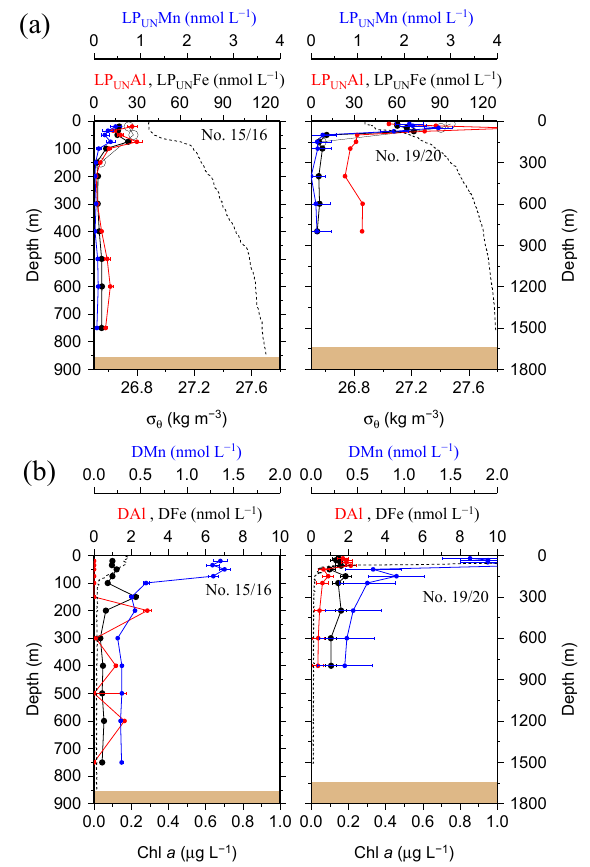
Figure 5. (a) OTE seawater samples: distribution of leachable par- ticulate manganese (LP Un Mn in blue), iron (LP Un Fe in black), and aluminium (LP Un Al in red) concentrations in the water column of the two other stations located on the island shelf edge (>700m wa- ter depth). SAPS samples: the particulate Fe (PFe) is illustrated by black circles and corresponds to the concentration labels of LP Un Fe. Error bars represent the standard deviation of the analysis. Density ( σ θ ) is illustrated by the black dashed line. (b) OTE sea- water samples: dissolved manganese (DMn), iron (DFe), and alu- minium (DAl) are represented by the same colour code as for the upper row. Dashed line illustrates the Chl a content of the water column recorded by the CTD-mounted